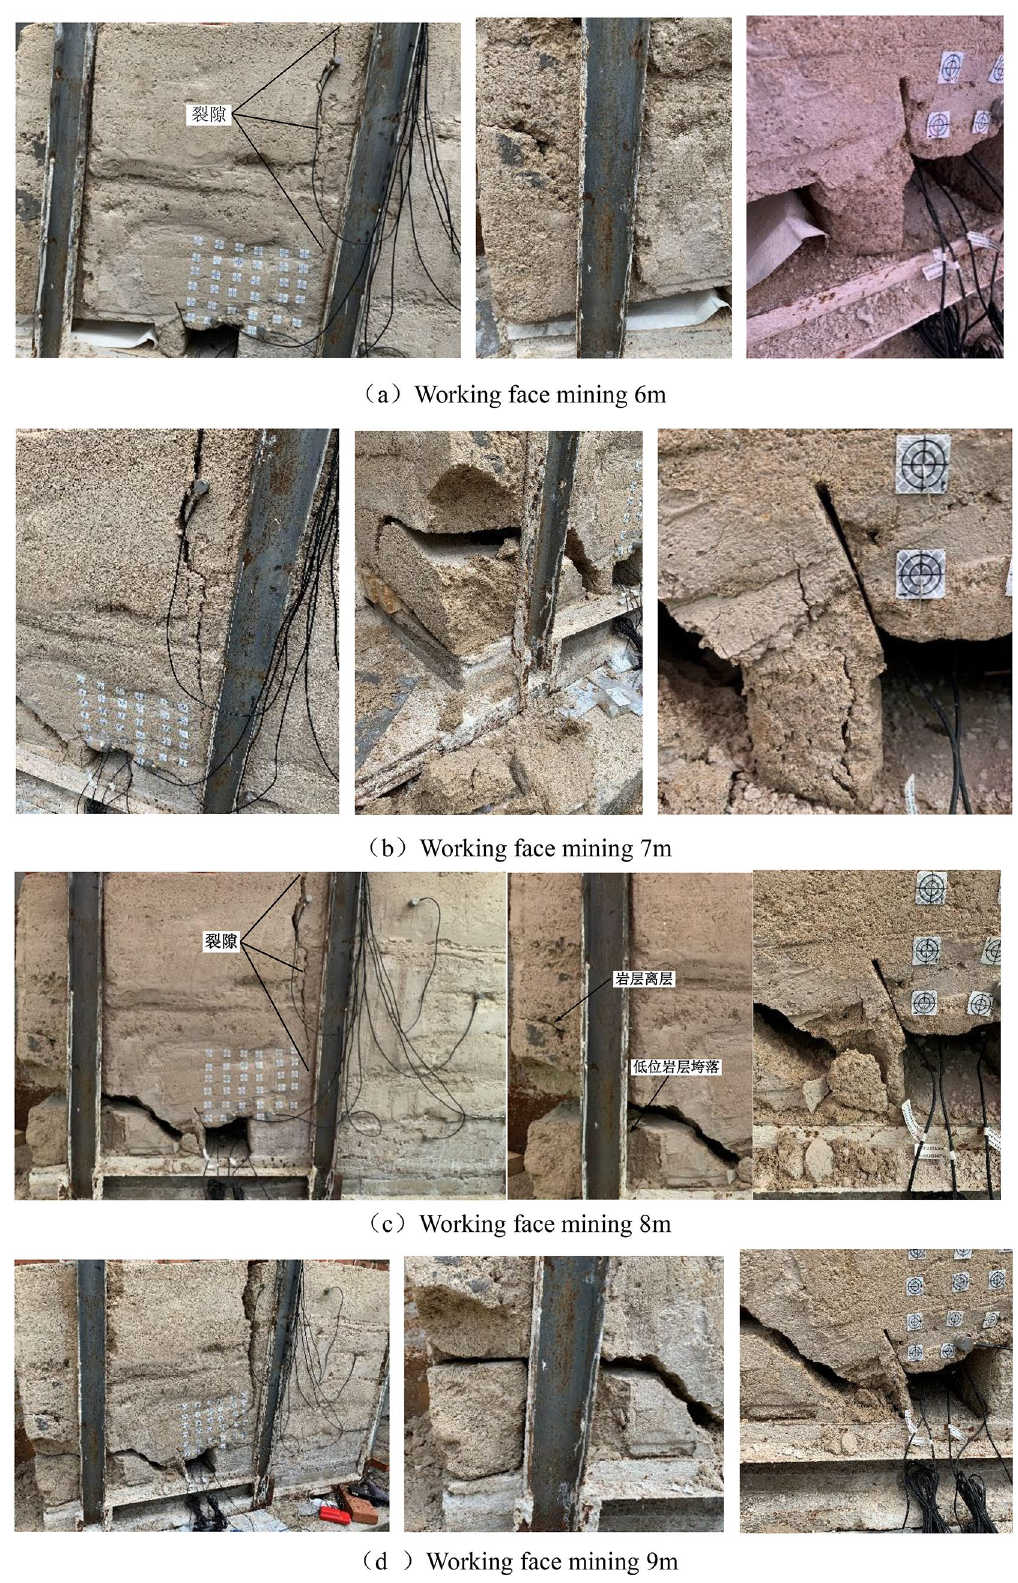
Figure 6. Overburden collapse process during